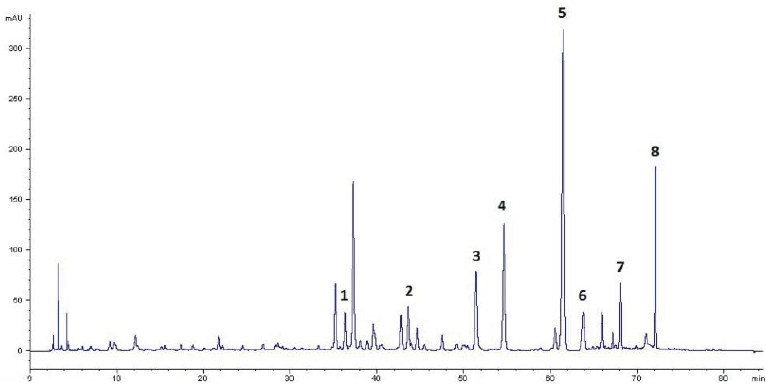
Figure 1. RP-LC/PDA chromatogram (recorded at 260 nm) of major isoflavone constituents found